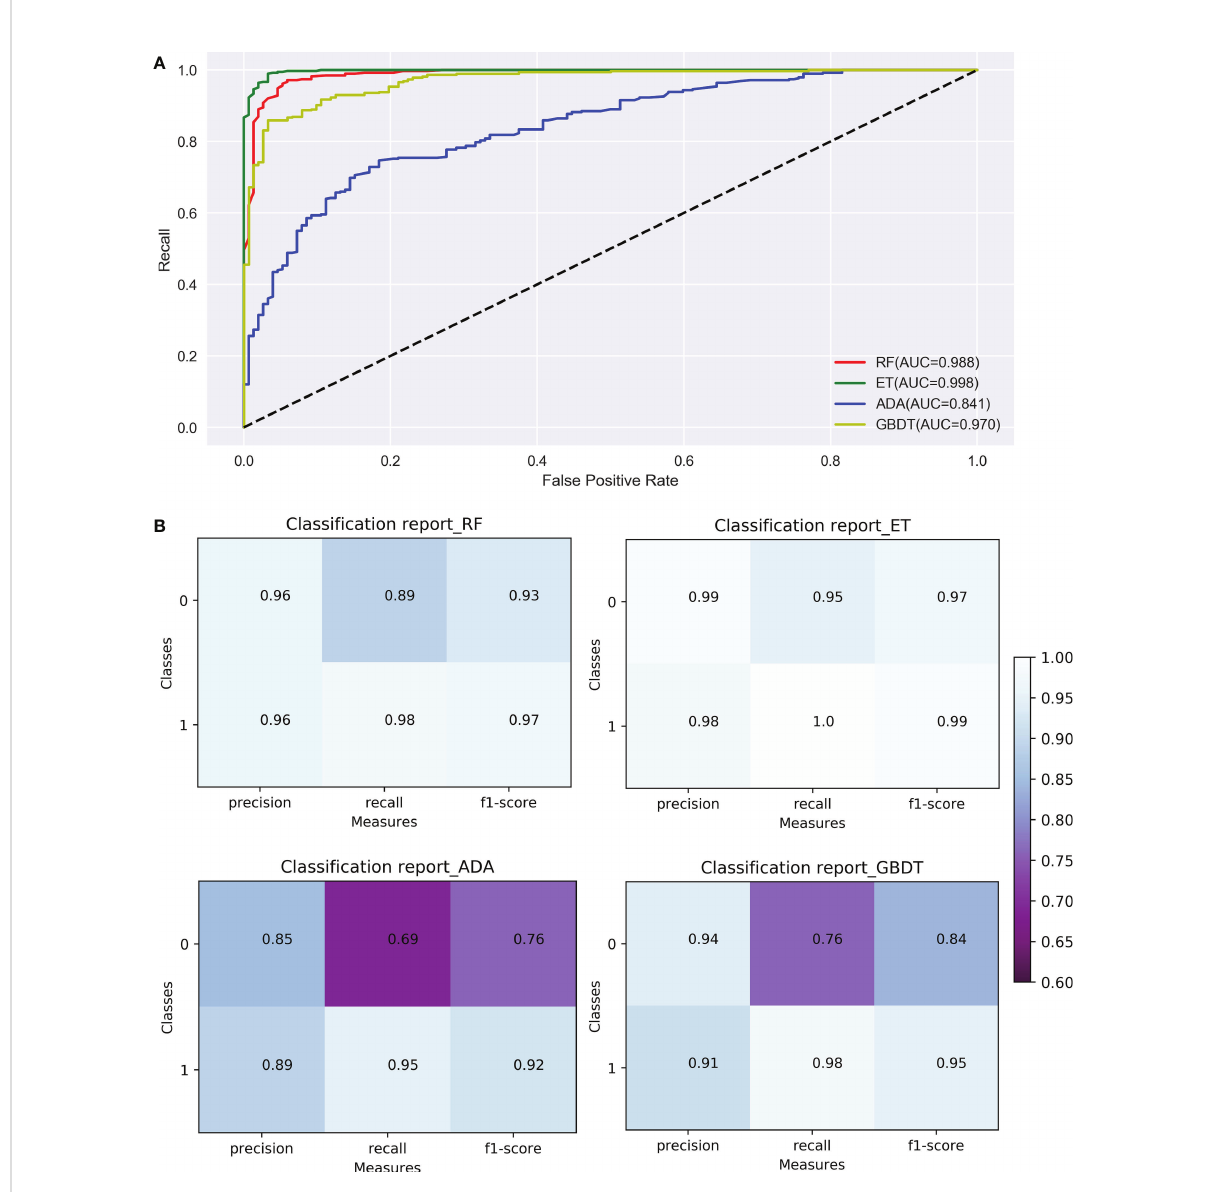
FIGURE 6 Comparison of ROC curves (A) and confusion matrix (B) of the 4 models (RF, ET, ADA, GBDT). RF, Random Forest; ET, Extremely randomized trees; ADA, Adaptive Boosting; GBDT, Gradient Boosting Decision Tree; Classes: 0 indicates healthy ginseng, 1 indicates diseased